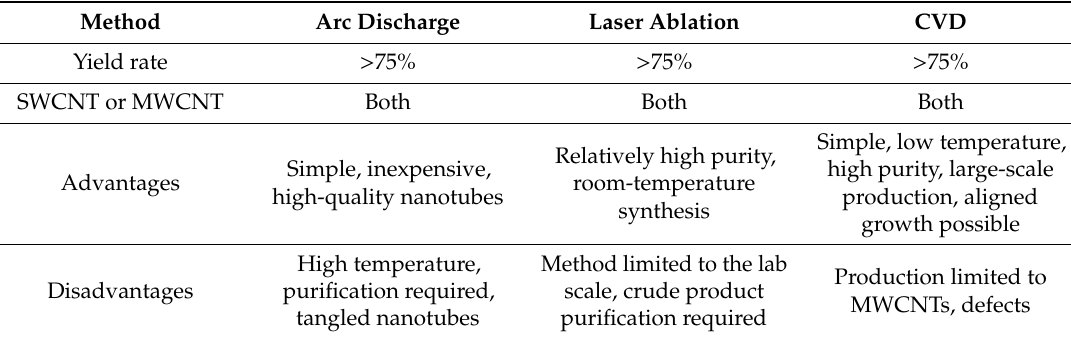
Table 1. Summary and comparison of three most common CNT synthesis